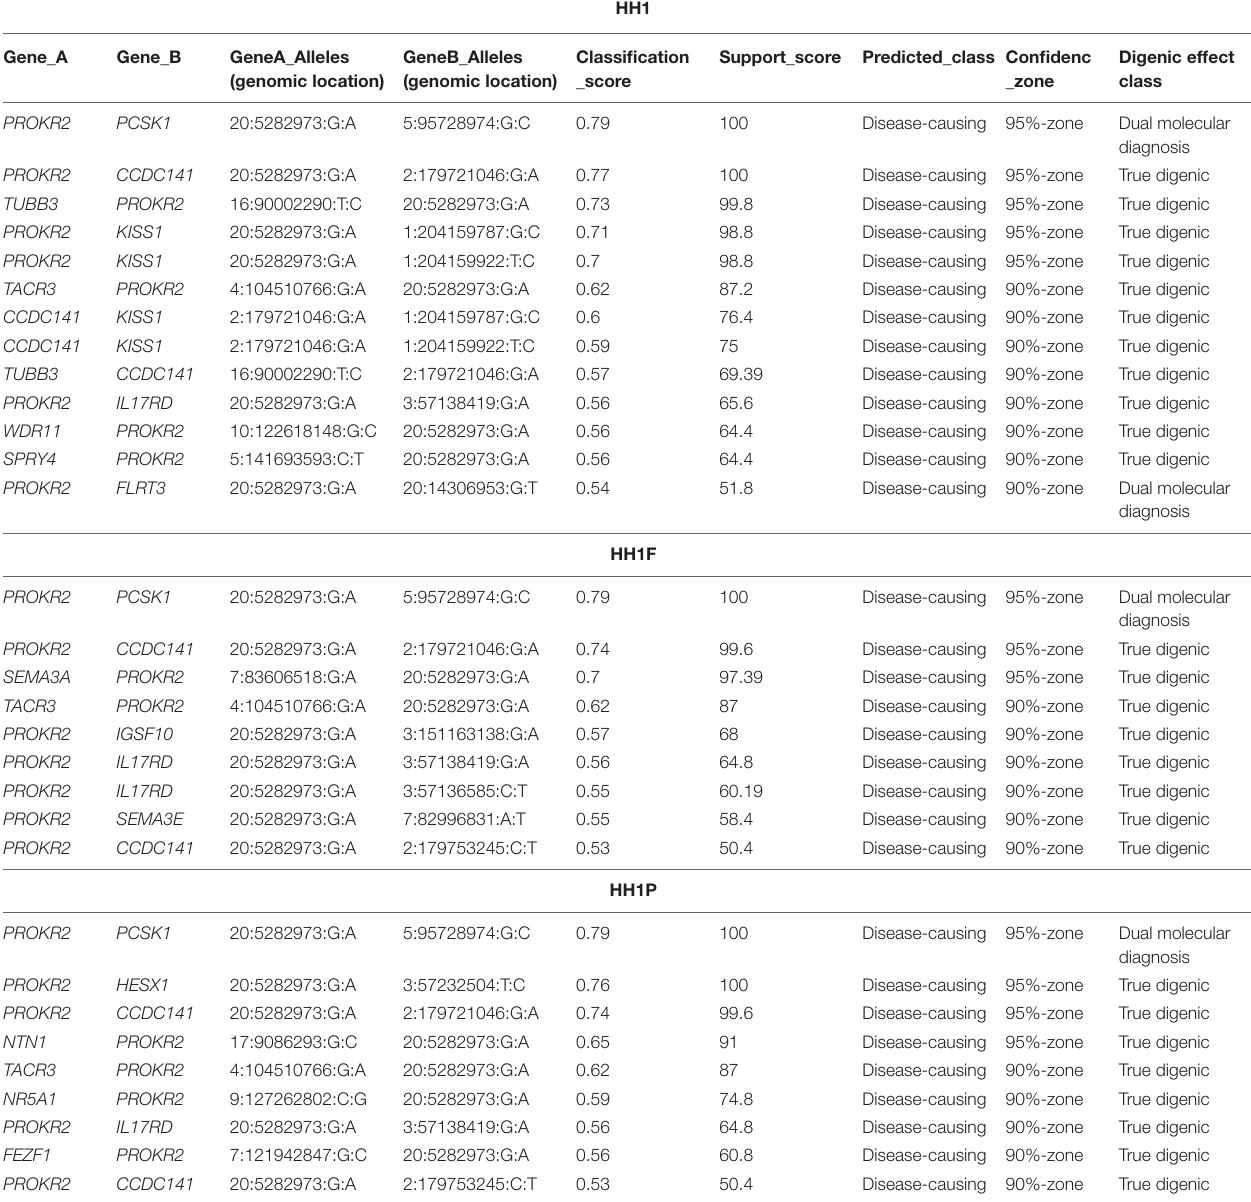
TABLE 2 | Disease-causing digenic combinations involving specific variants found in the three HH1 family members. HH1 Gene_A GeneA_Alleles GeneB_Alleles Classification (genomic location) (genomic location)